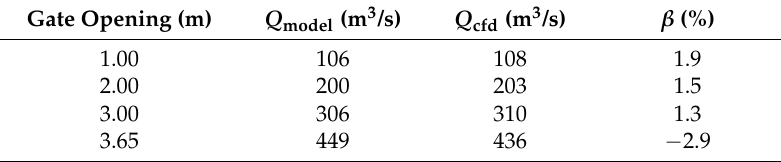
Table 6. Storfinnforsen bottom outlet, comparisons of Q model and Q cfd at fixed gate openings. Gate Opening